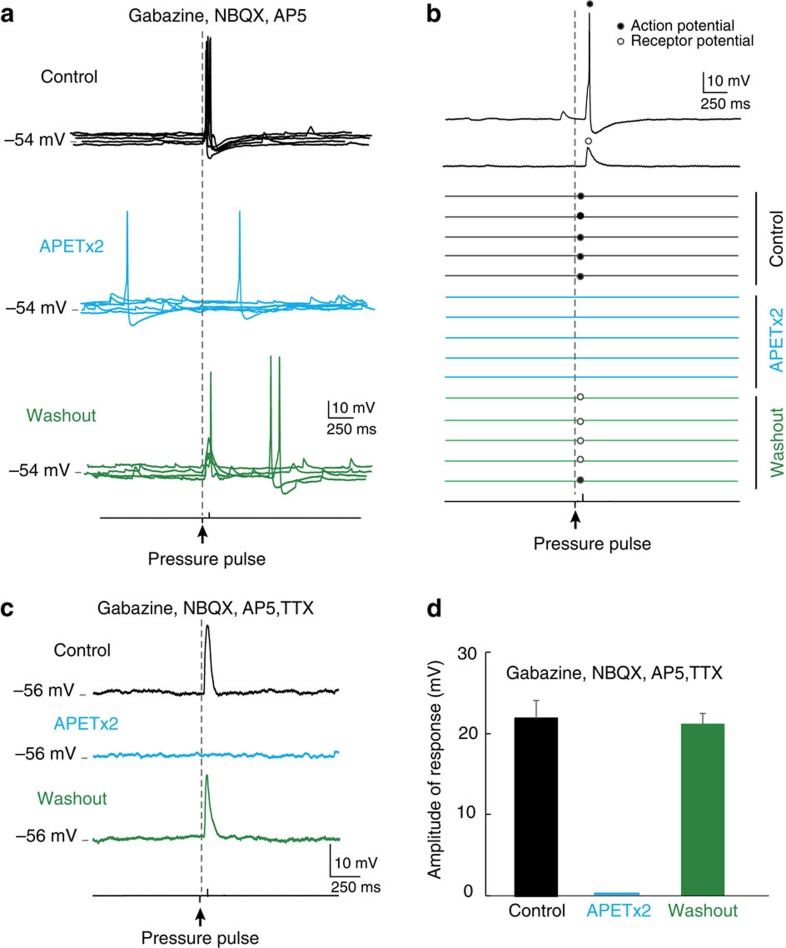
APETx2 inhibits the mechanosensitivity of CSF-c neurons.(a) Fluid-pulse stimulation (20 p.s.i., 80 ms) elicited action potential responses in control conditions (black) in the presence of gabazine (20 μM), AP5 (100 μM) and NBQX (40 μM). Application of the ASIC3 blocker APETx2 (2 μM) abolished responses (blue), which partially recovered upon washout (green). (b) Raster plot showing reliable responses to pressure stimulations (20 p.s.i., 80 ms) in control, and which were completely abolished by application of APETx2. Responses reappeared upon washout. (c) The receptor potential elicited by fluid pulses (20 p.s.i., 60 ms) was also blocked by APETx2 in the presence of TTX (1.5 μM). (d) Complete blockade of responses after application of APETx2 (n=6). Means±s.e.m.